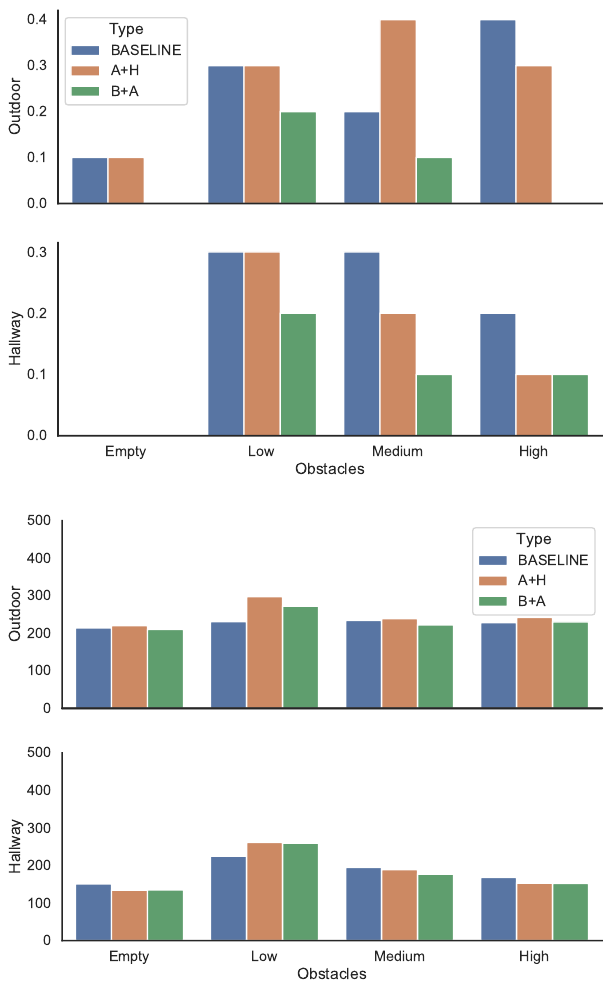
Figure 6. (top) Efficacy of the navigational guidance system for configurations A and B, measured as the percentage of the obstacles in the environment that were hit during the navigation (lower is better); and (bottom) time needed to perform a navigation task (lower is